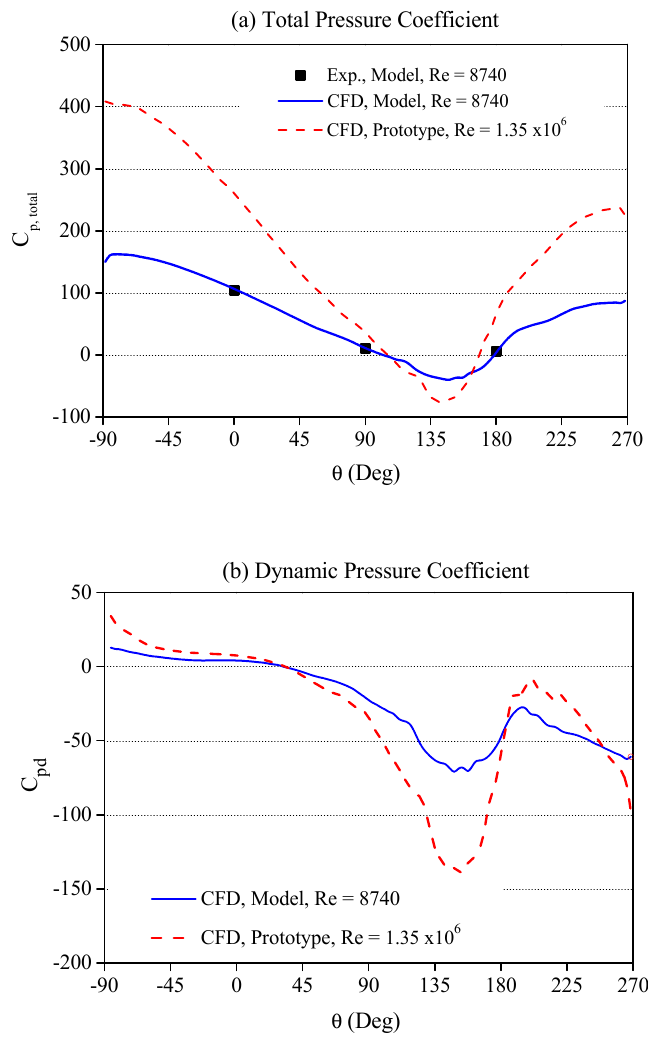
Figure 11. Comparison of simulated pressure coefficients on the surfaces of scaled-down model and prototype circular dams. ( a ) Total pressure; ( b ) dynamic pressure.